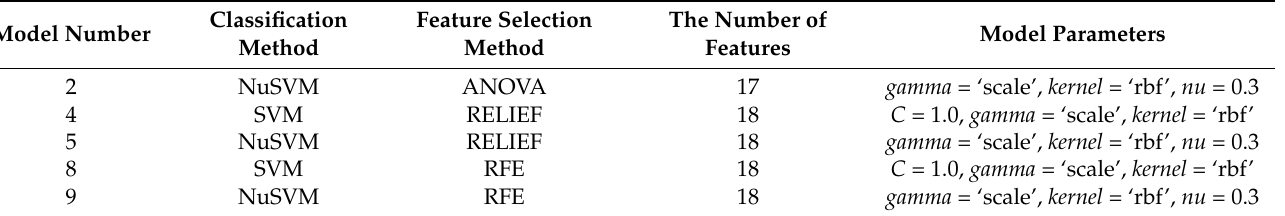
Figure 6. The sensitivity ( TPR ) and specificity ( TNR ) of the models that have reached the highest value of the overall classification accuracy ( ACC ): ( a ) bone reconstruction; ( b ) soft-tissue reconstruction. Table 3. Information on the structure of models considered most effective for soft-tissue reconstruction.